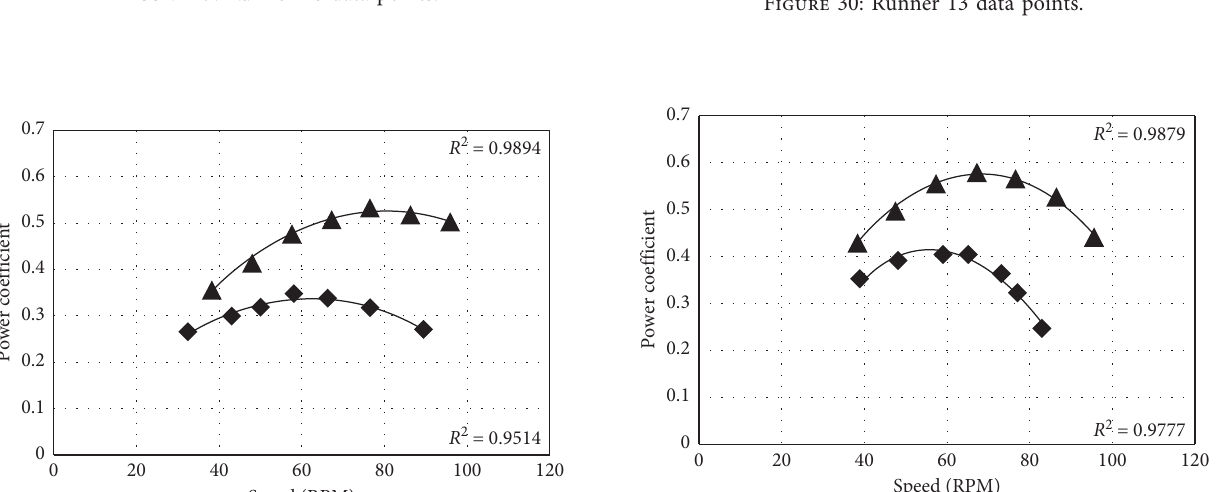
Figure 27: Runner 10 data points.